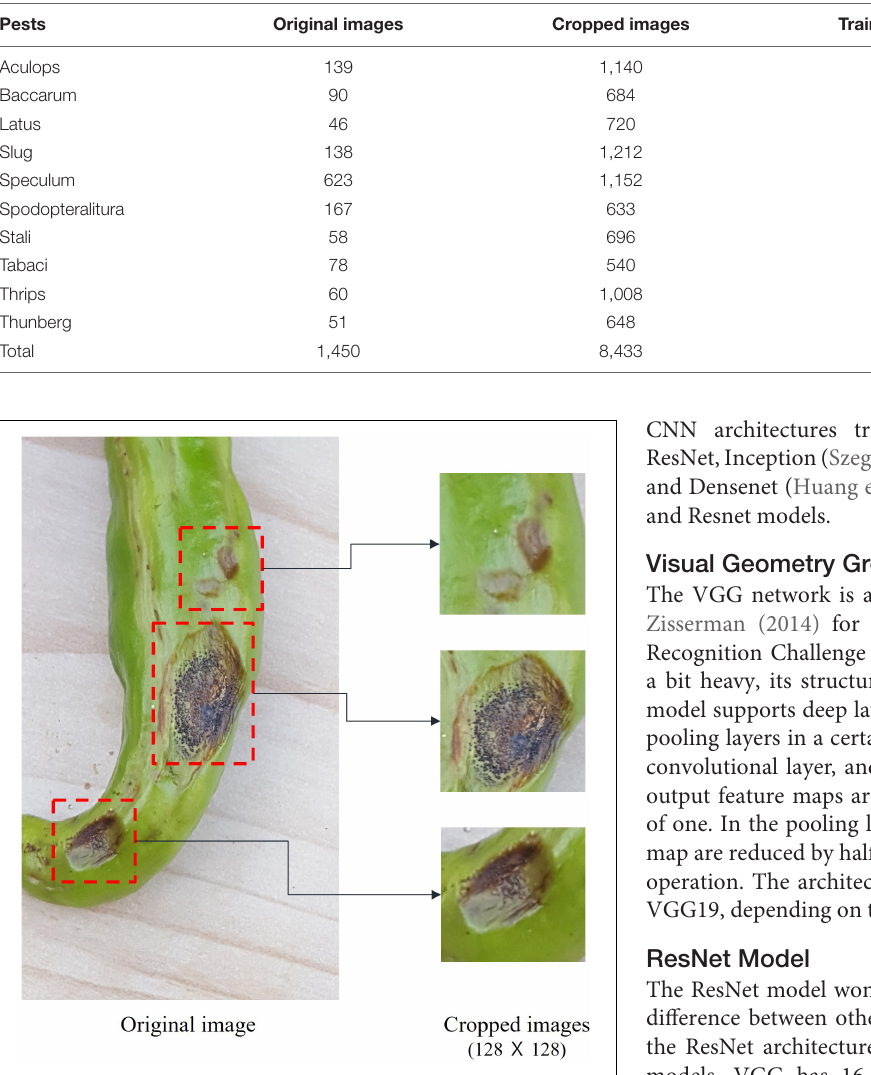
TABLE 2 | Summary of hot pepper pest dataset.